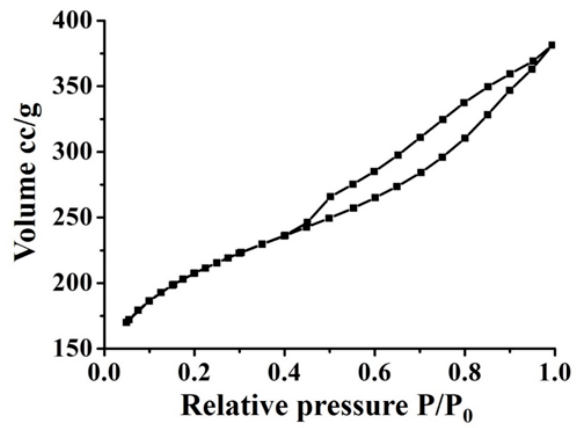
Figure 7. Nitrogen adsorption isotherm for optimum bio-PAC after activation.